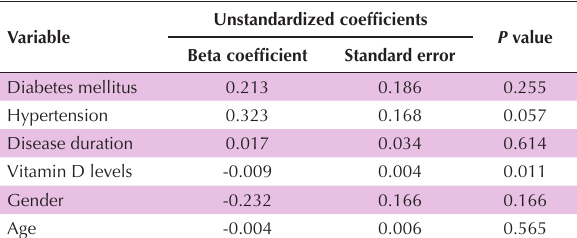
Table 4 . Linear regression to predict the neutrophil-to-lymphocyte ratio